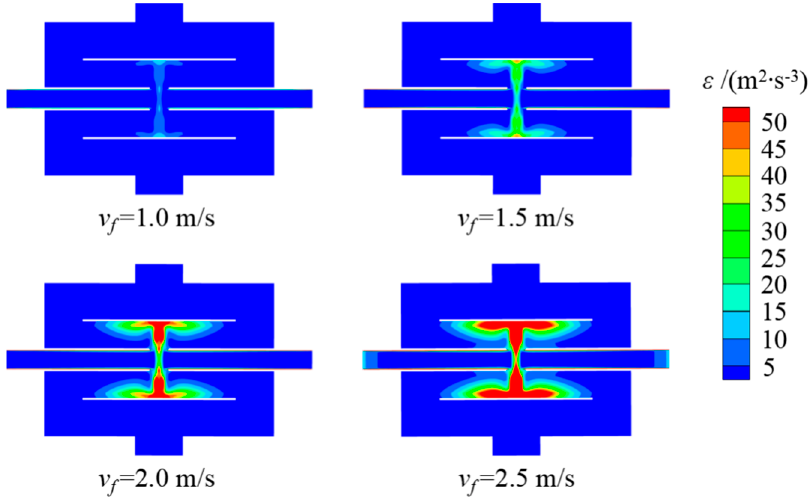
Figure 6. Turbulent dissipation rate nephograms of the CFPCD for different feeding velocities.